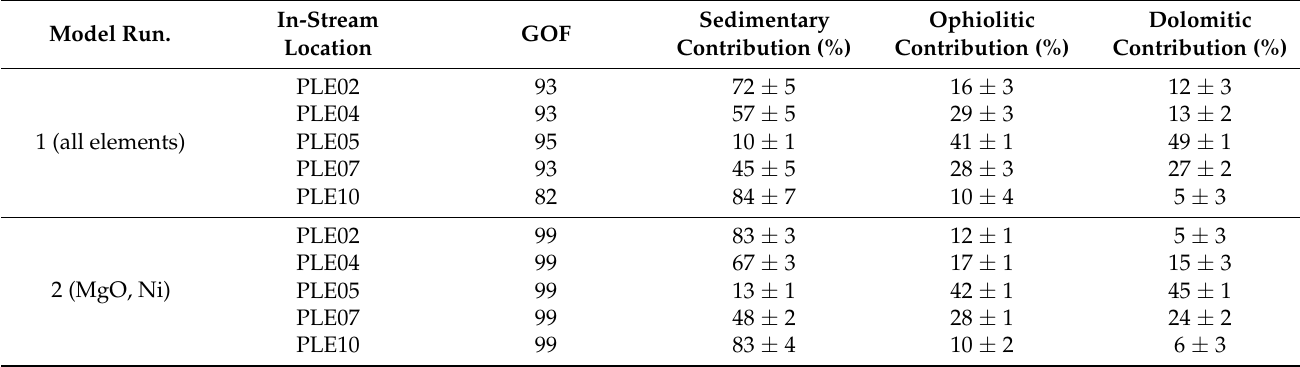
Table 4. Comparison between two datasets used in the calculation of the relative contribution of the three selected endmembers. In-stream locations are displayed in Figure 2. The uncertainties of the relative contribution are given as standard deviation. Goodness of fit (GOF) expresses the quality of the model. varying from 0 to 100. Model Run.